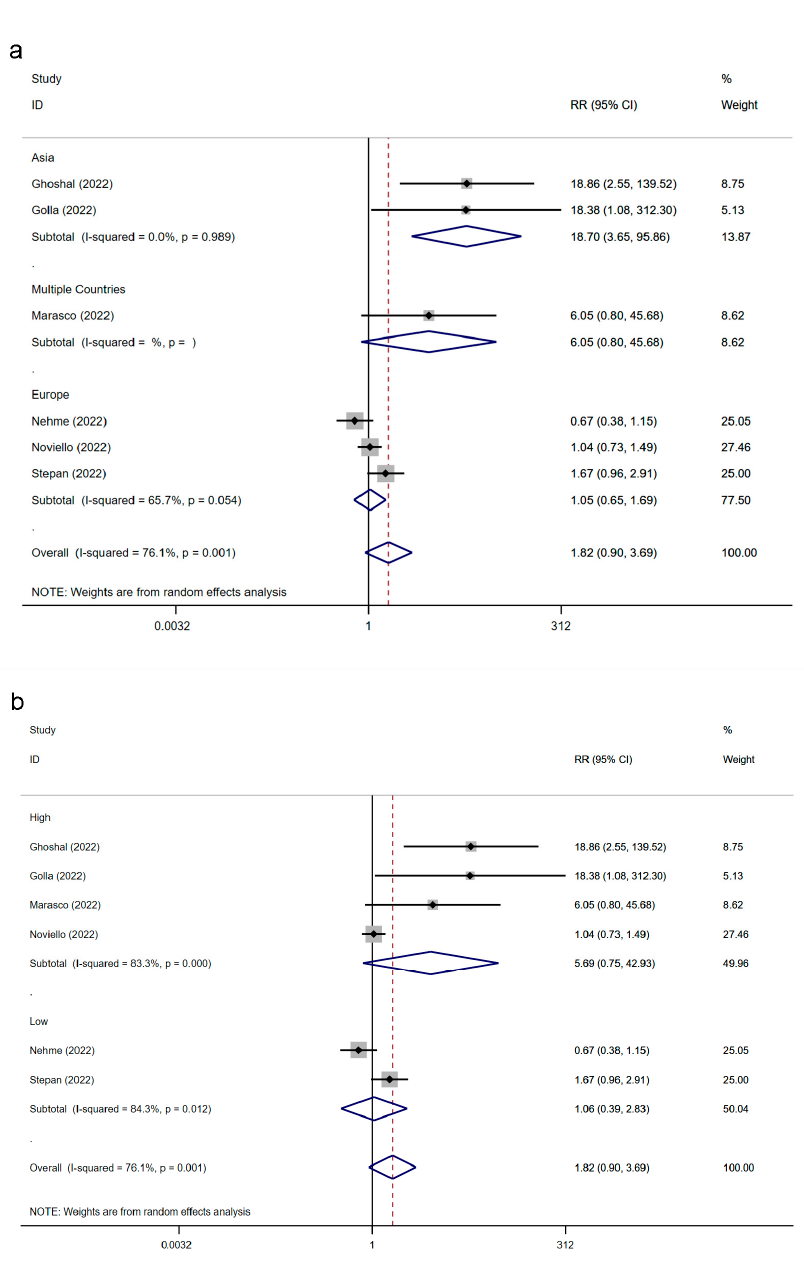
Figure 5. Subgroup analysis of the association between IBS and SARS-CoV-2 infection [22,23,34– 36,38]. Forest plots classified by region ( a ) and study quality ( b ). IBS, irritable bowel syndrome; SARS-CoV-2, severe acute respiratory syndrome coronavirus 2; RR, risk